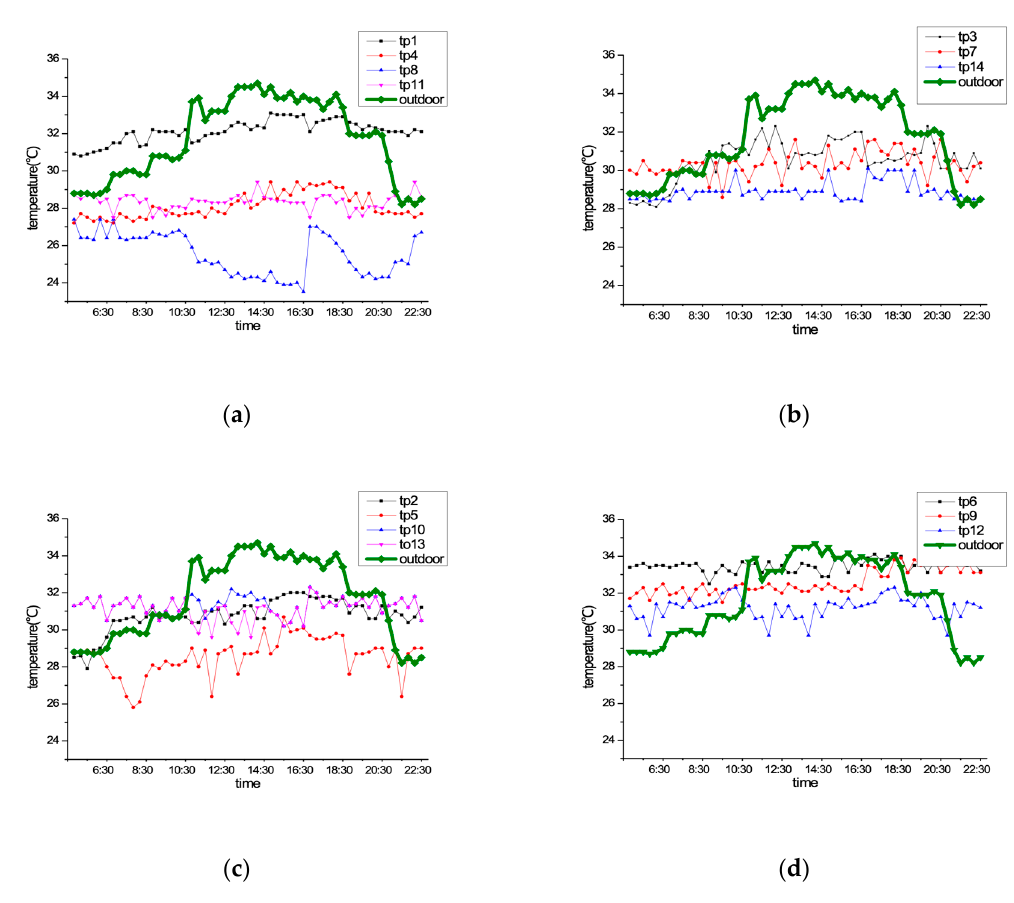
Figure 11. Comparison curves of hourly temperature data for each point during the monitoring day. ( a ) Middle tubular space; ( b ) Tube entrance (connection to building); ( c ) Tube entrance (connection to subway); ( d ) Station hall.